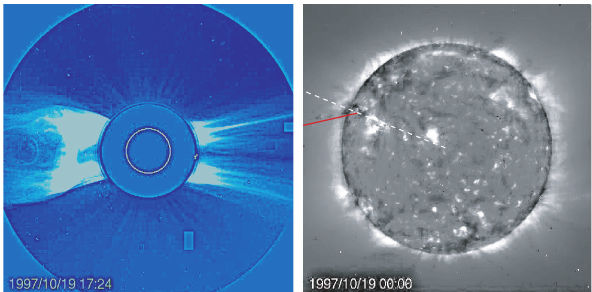
Fig. 4. CME on 19 Oct 1997 in a field of view of SOHO/LASCO C2 (left) and composite differential image obtained from a series of SOHO/EIT Fe XII 195 line images (right). A chain of dark and bright nodes above the red line traces the path of the eruptive promi- nence. The trajectory deviates more than 30 ◦ southward from the radial direction, shown with the white dashed line. The shape of the CME is nearly symmetric about the equatorial plane and it moves radially. (Courtesy of SOHO/EIT and SOHO/LASCO consortiums. SOHO is a joint ESA-NASA